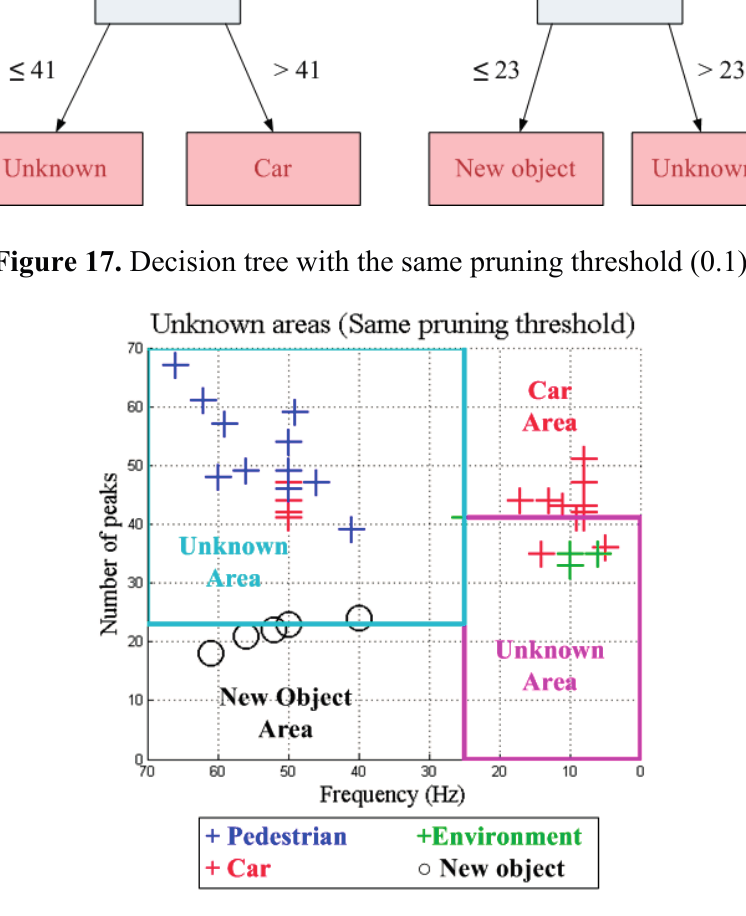
Figure 18. Unknown areas with the same pruning threshold